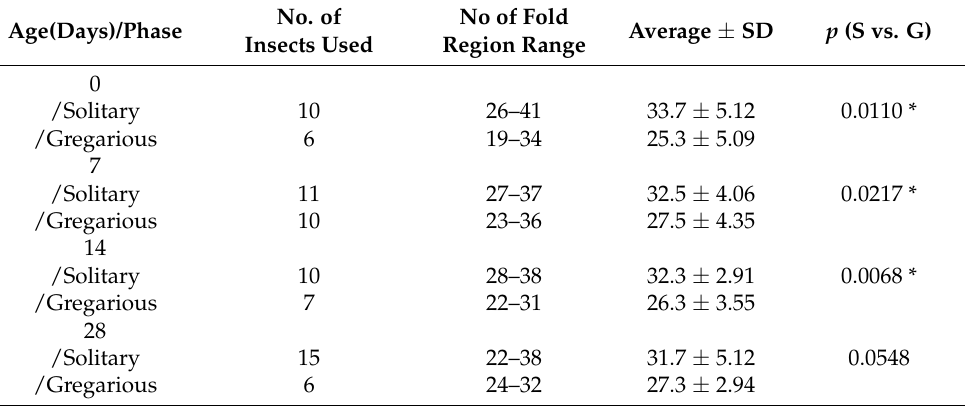
Table 3. The number of fold regions of the seminal vesicle compared between solitary (S) and gregarious (G) phases in the desert locust Schistocerca gregaria . No. of No of Fold Age(Days)/Phase Insects Used Region